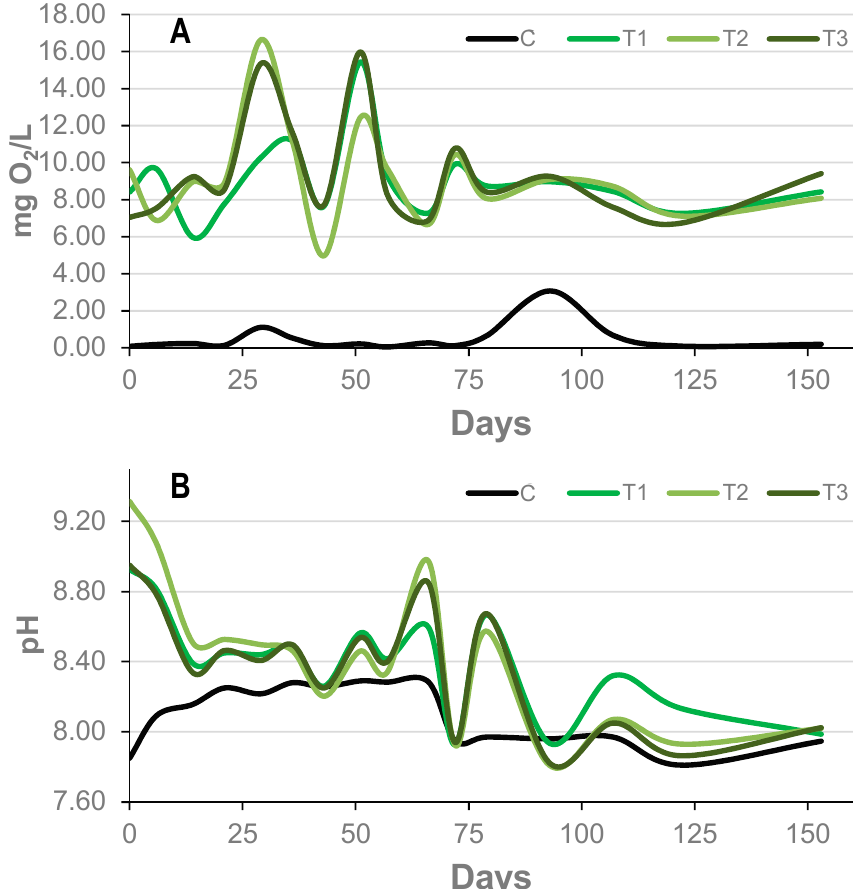
Figure 2. Evolution of dissolved oxygen (DO) ( A ) and pH ( B ) in the water column in the tanks with mats (T1–3, green lines) and in the control (C, black line) in the course of the experiment.